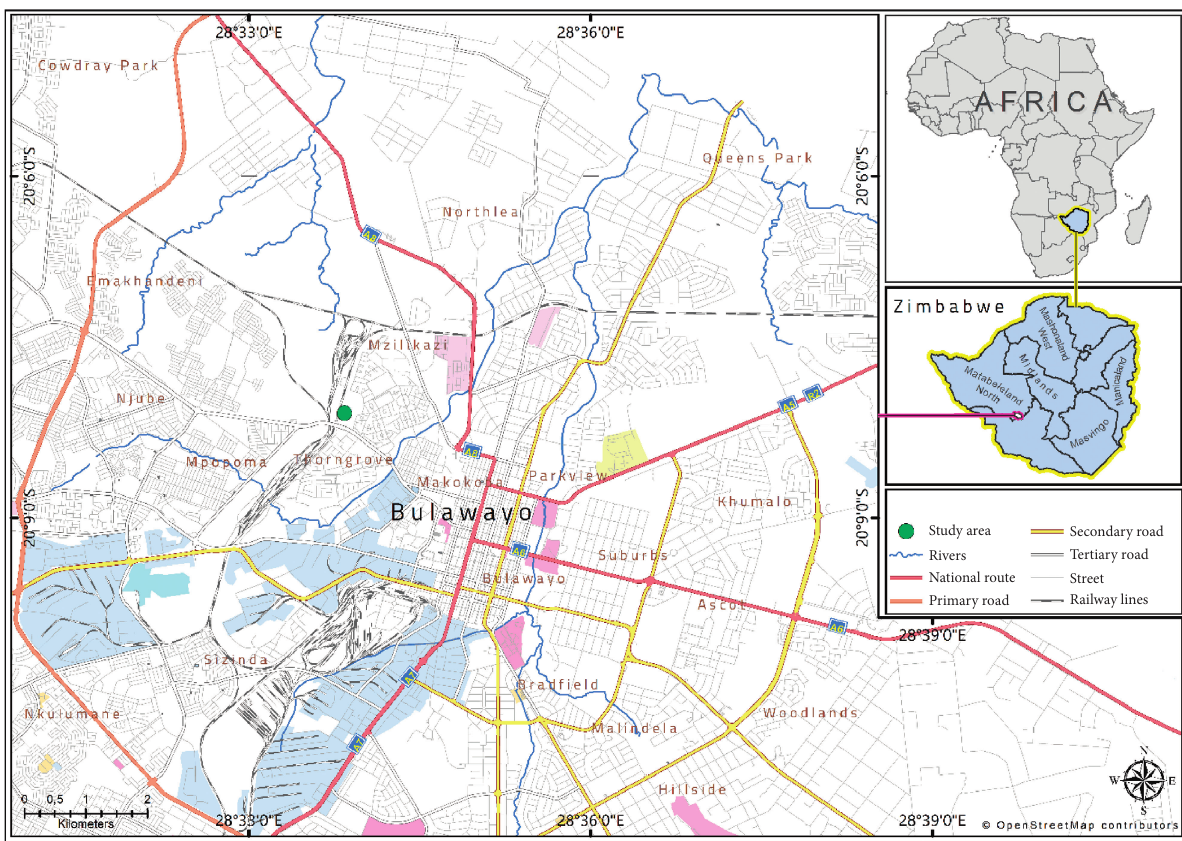
Figure 1: Location map of Lumberstewart